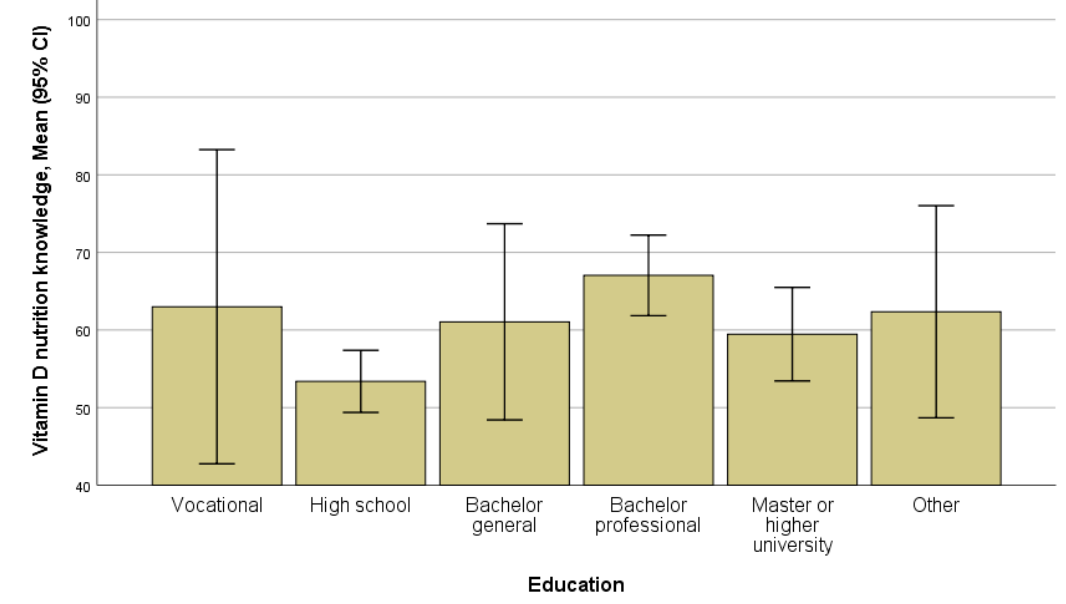
Figure 3. Scores for vitamin D nutrition knowledge in education groups ( p = 0.014,